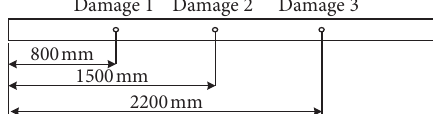
Figure 21: Damage locations along the axial